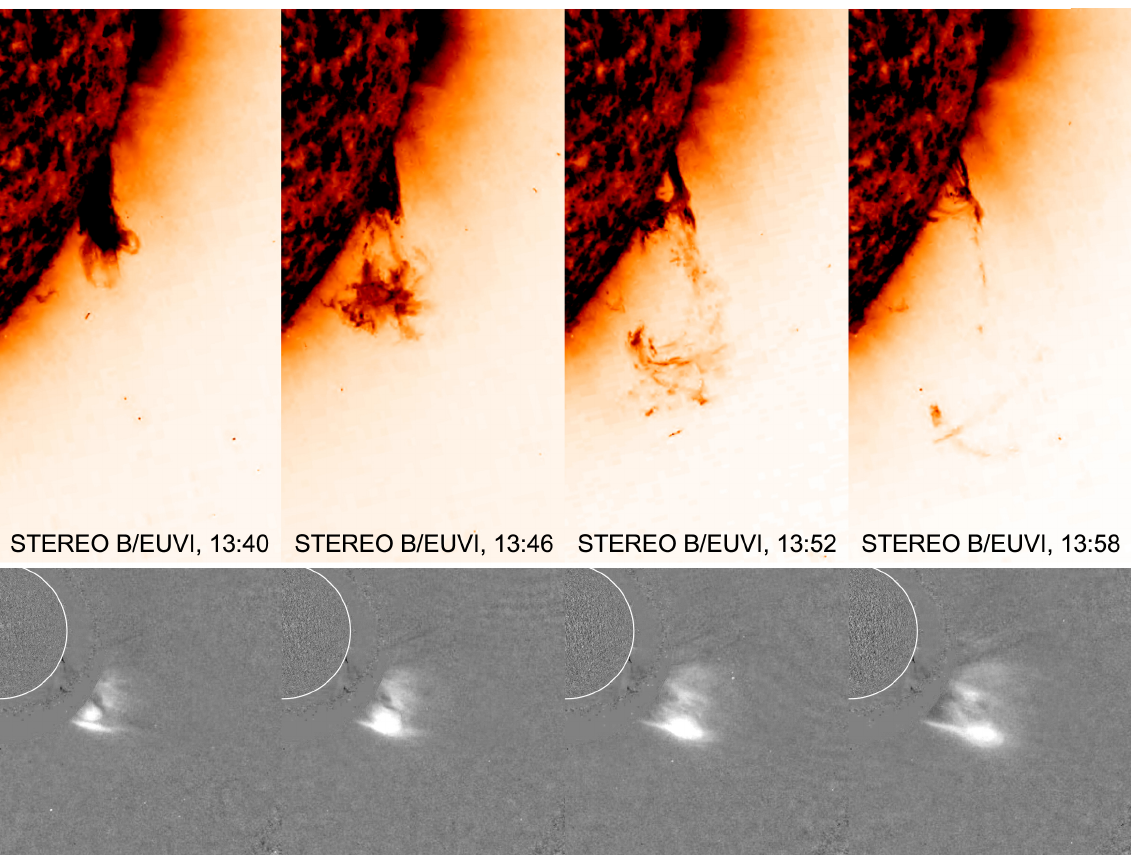
Fig. 1. Top: sequence of He II λ 304 images acquired by the EUVI telescope on the STEREO-B spacecraft showing the erupting prominence object of the present study. Images are plotted in reverse color scale, hence darker features correspond to a brighter He II emission and vice- versa. Bottom: the resulting coronal mass ejection as observed by the COR1 coronagraph aboard STEREO-B (sequence of base difference images; brighter features correspond to relative column density